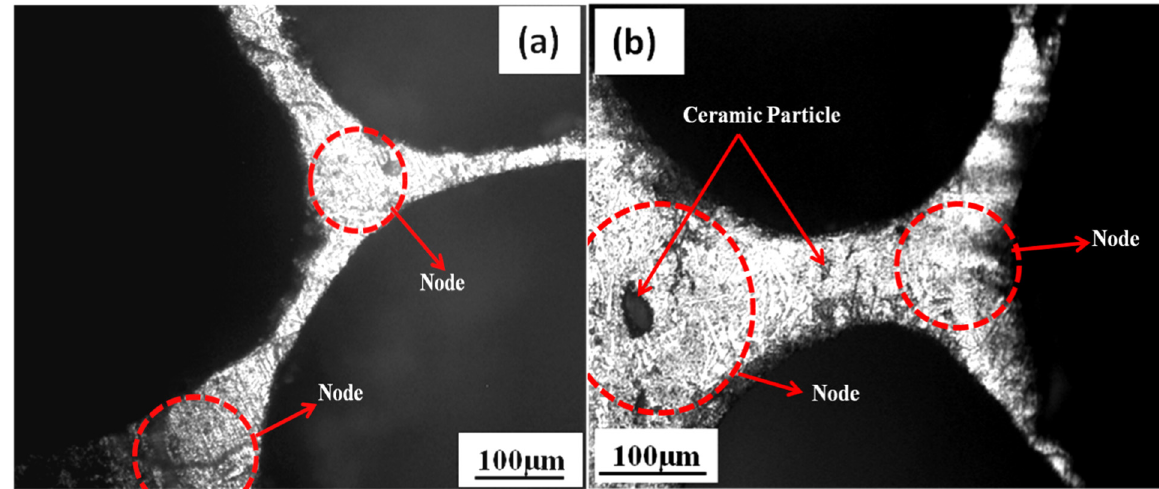
Figure 8. The images of ligament and node of ( a ) LM13 alloy foam and ( b ) composites foam at 850 °C.